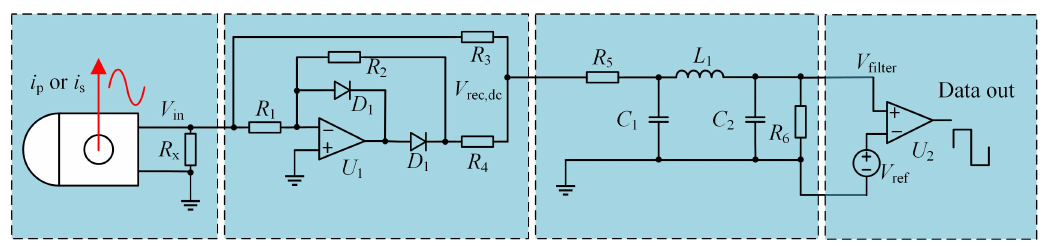
Figure 10. Circuit of demodulator.